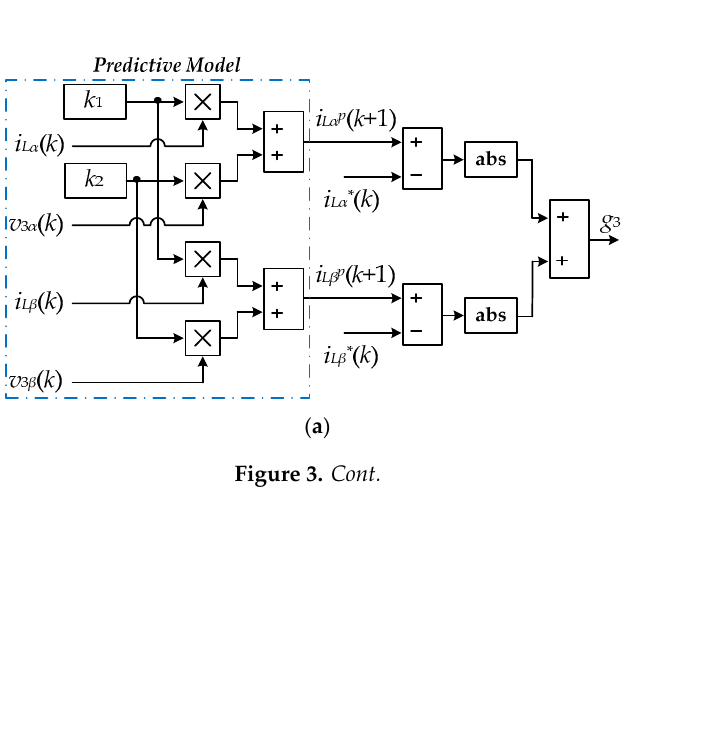
Figure 2. Schematic diagram of load current control using finite set-model predictive control (FS-MPC) in ( a ) αβ -frame and, ( b ) dq -frame.